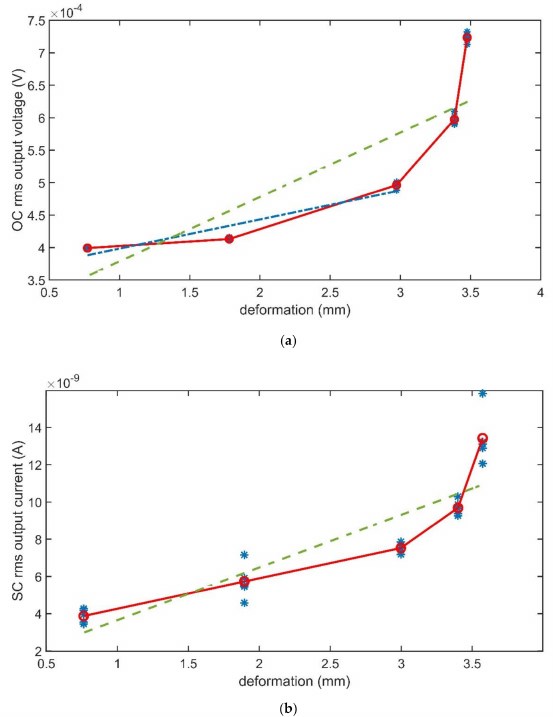
Figure 12. Rms values of the BC-CP OC voltage ( a ) and SC current ( b ) at the composite mechanical resonance frequency (12 Hz) as a function of the